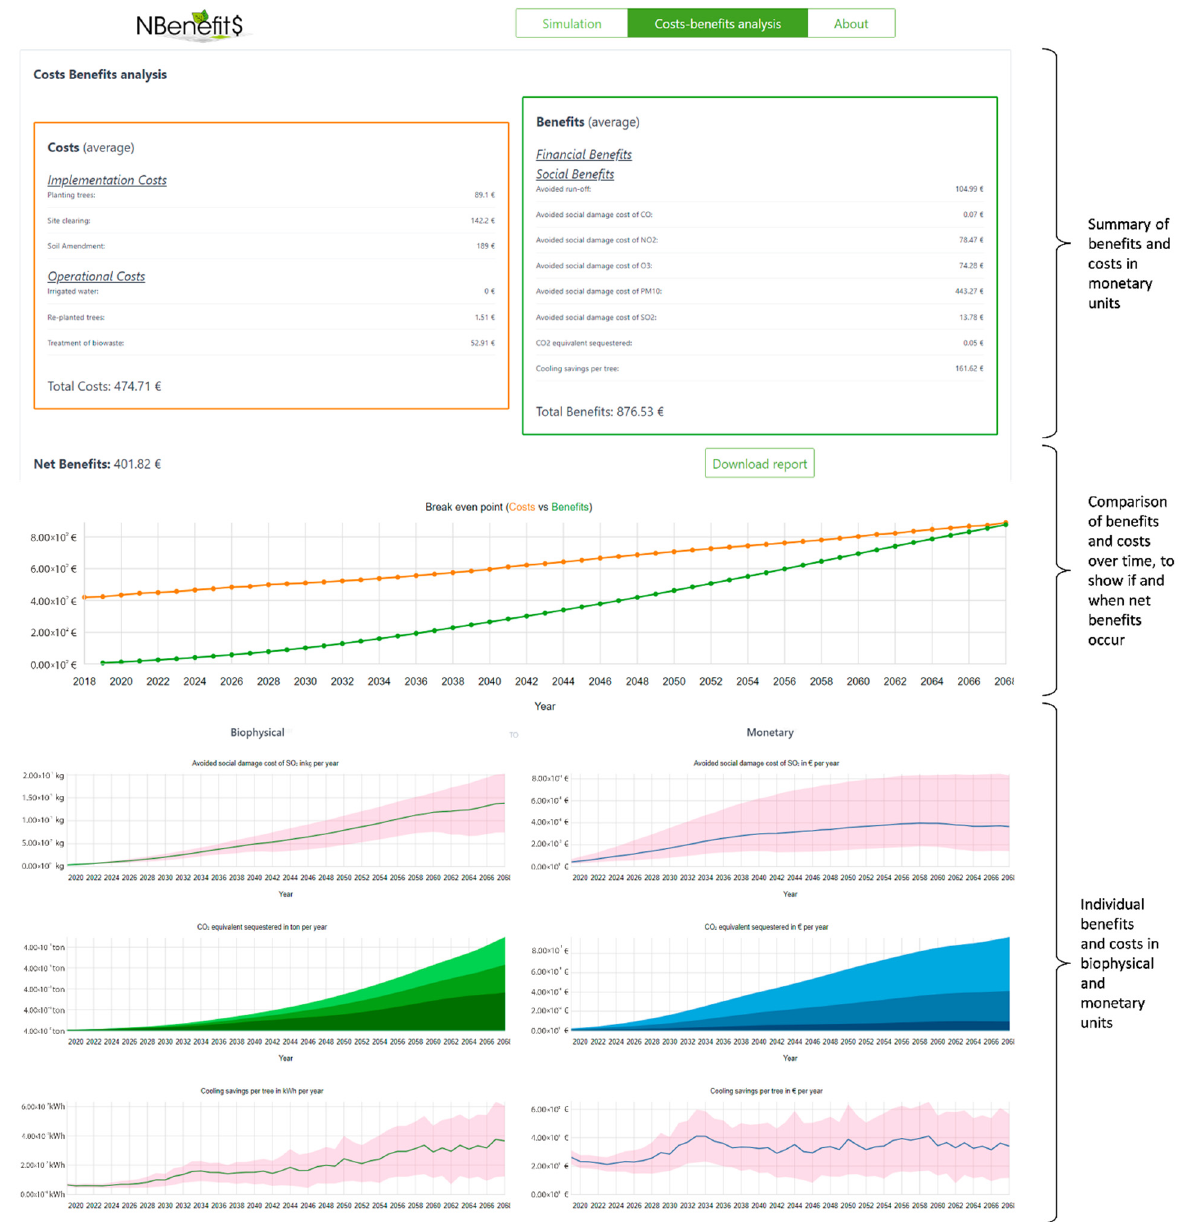
Figure 7. Online summary of the cost-benefit analysis and graph visualisation generated by the web user interface in NBenefit$.